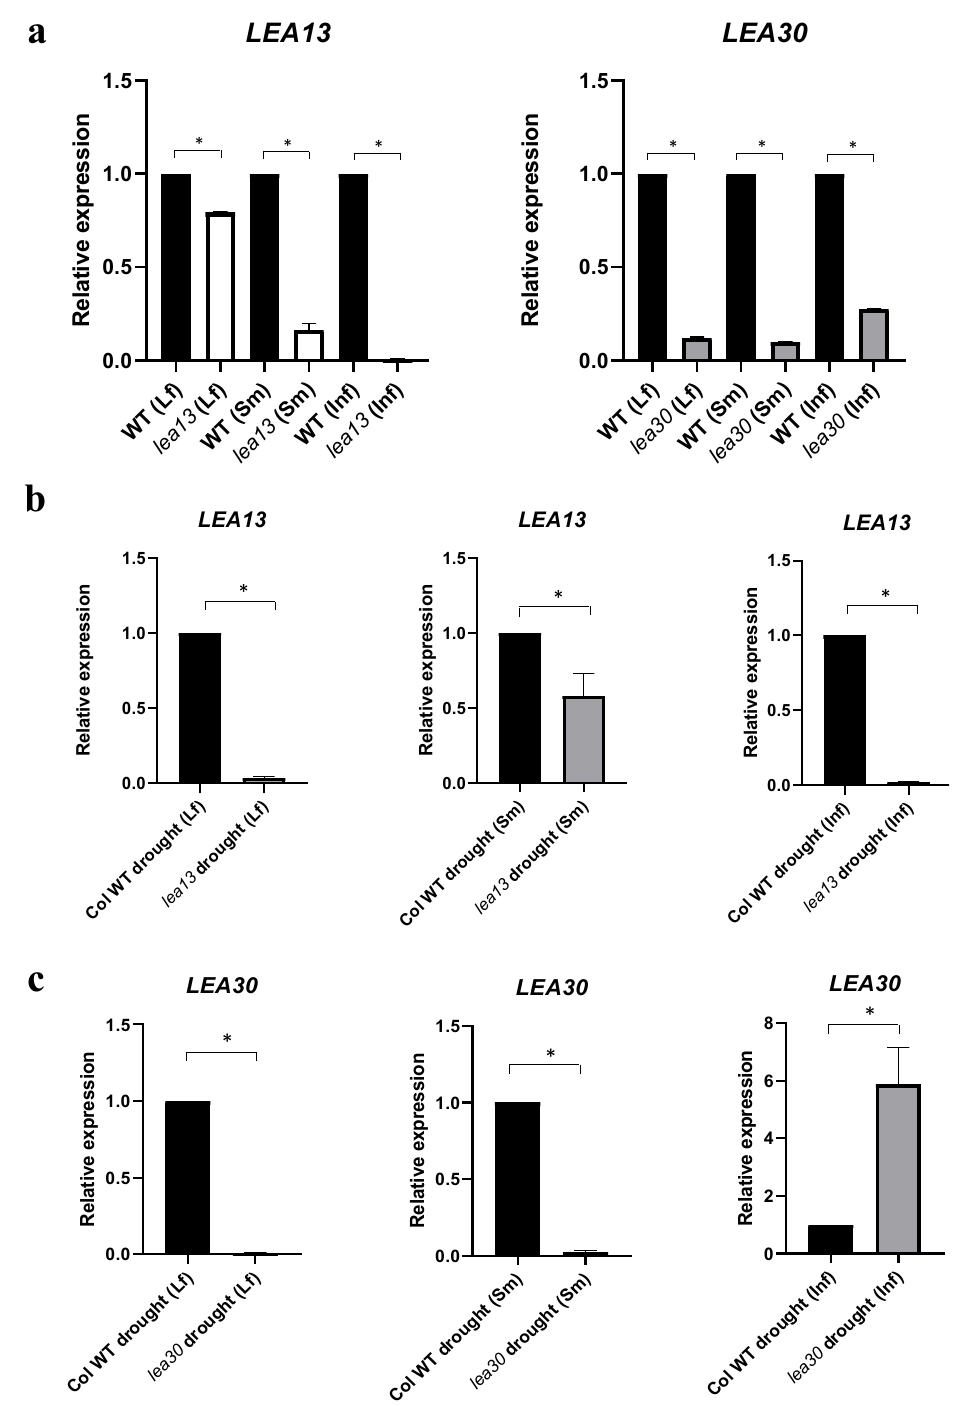
Figure 4. The expression pattern of LEA13 and LEA30 genes in lea13 and lea30 during tolerance to water stress. ( a ) Relative expression of LEA13 in background lea13 and relative expression of LEA30 in background lea30 . ( b ) Relative expression of LEA13 in background lea13 during tolerance to water stress. ( c ) The relative expression of LEA30 in background lea30 under water stress conditions. Abbreviations: Sm (stem), Inf (inflorescence), and Lf (rosette leaf). After 10 days of water deficit. Y-axis: relative expression (2 − ∆∆ CT ). * Data represent samples significantly different p < 0.05. All tests were performed using 3 biological and technical replicates.